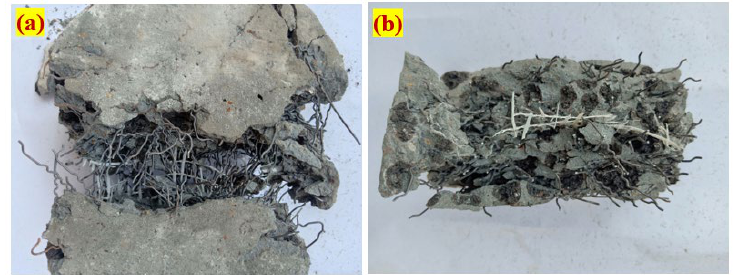
Figure 9. Fibre failure. ( a ) Fibre bridging; ( b ) Appearance of failure plane .